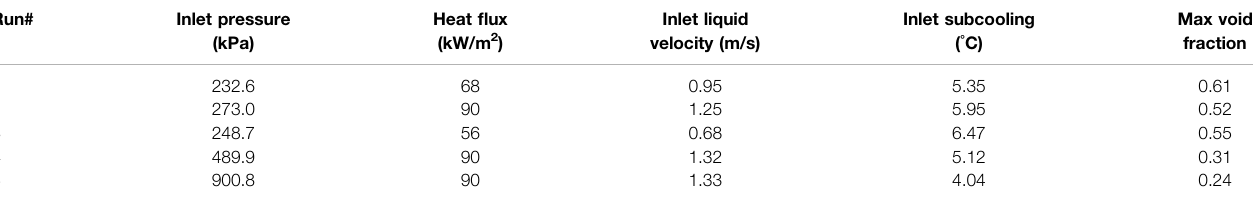
TABLE 2 | Summary of conditions considered in the benchmark.from the database of Bottini et al. (2020).